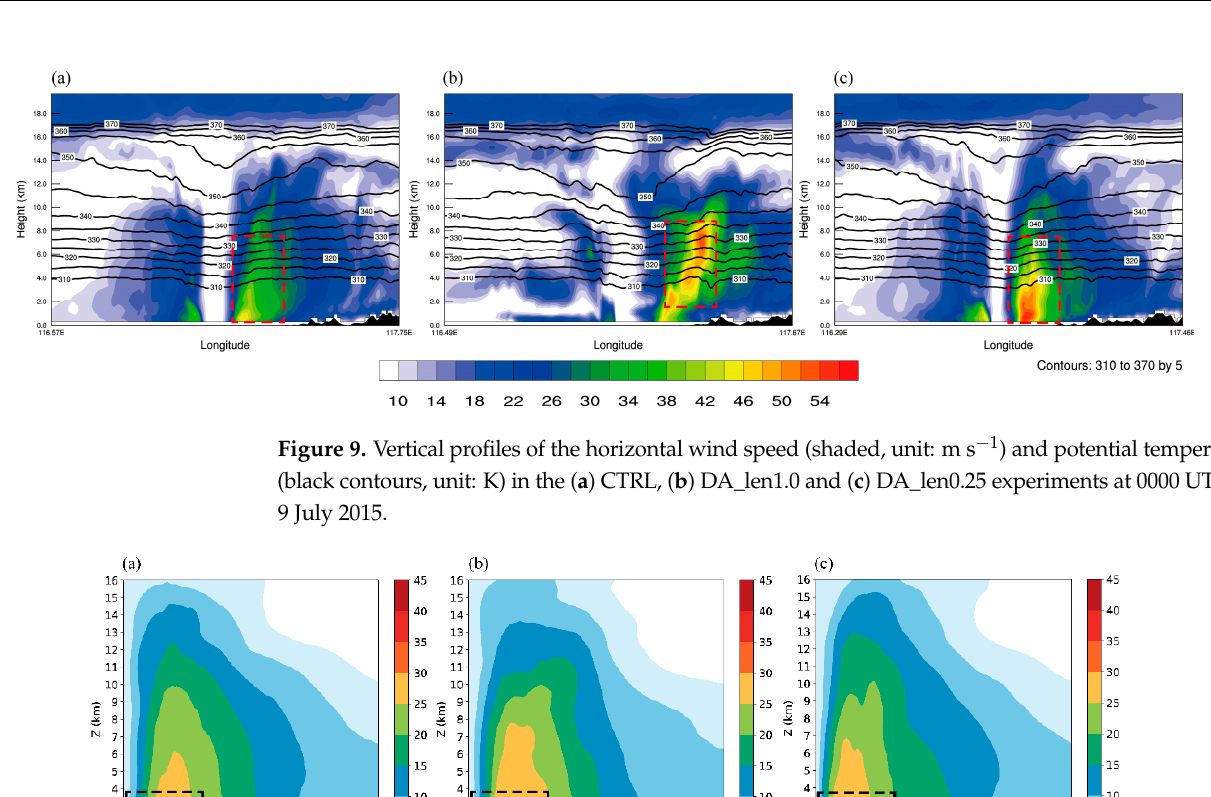
Figure 9. Vertical profiles of the horizontal wind speed (shaded, unit: m s − 1 ) and potential tempera- ture (black contours, unit: K) in the ( a ) CTRL, ( b ) DA_len1.0 and ( c ) DA_len0.25 experiments at 0000 UTC on 9 July 2015.